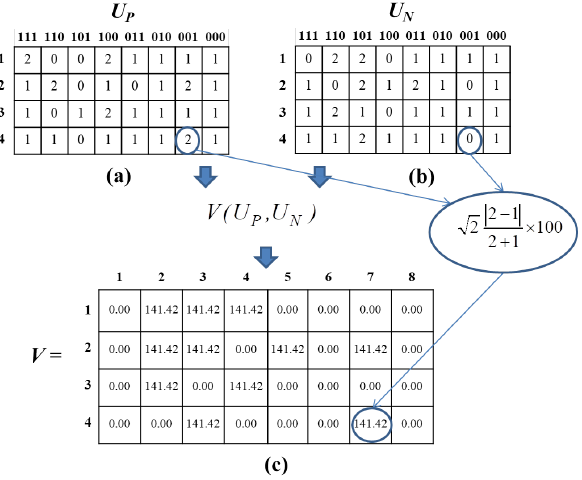
Figure 4. The Create Variance Decision Table process. ( a ) Initial rule matrix of positive data; ( b ) initial rule matrix of negative data; and ( c ) generating variance decision table.